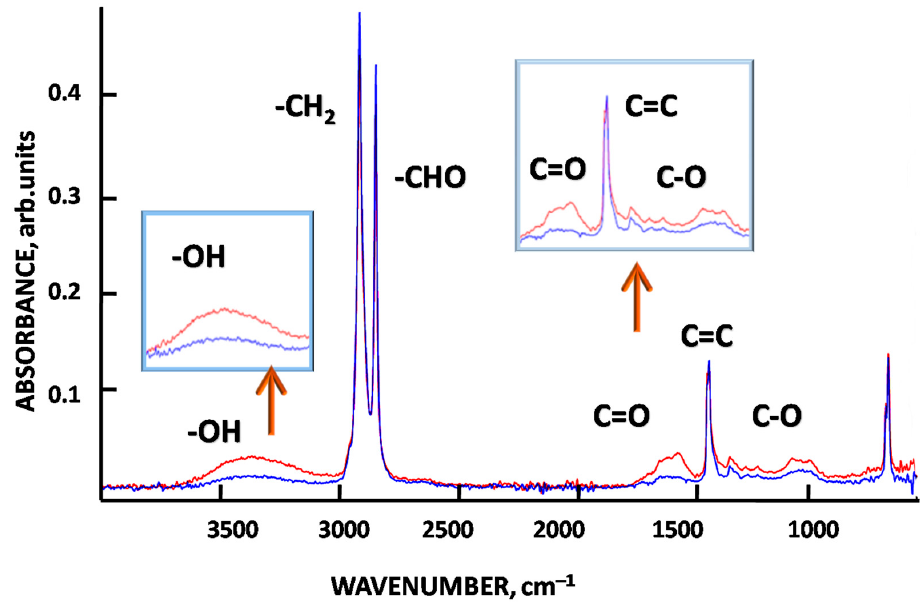
Figure 4. FTIR spectra of pristine HDPE (blue line) and ozonated HDPE membrane (600 s) (red line).